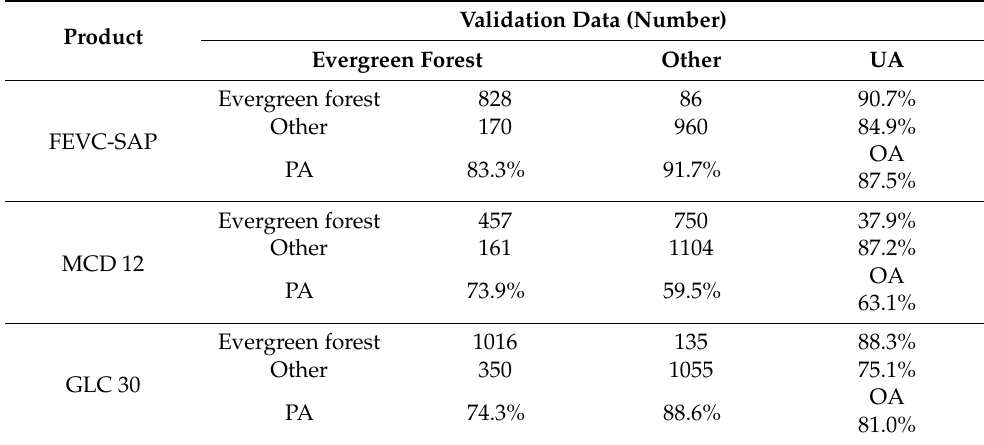
Table 3. Comparison of extraction accuracy of FEVC-SAP model with those of other products. UA, user accuracy; PA, producer accuracy; OA, overall accuracy. Validation Data (Number) Product Evergreen Forest Other UA Evergreen FEVC-SAP